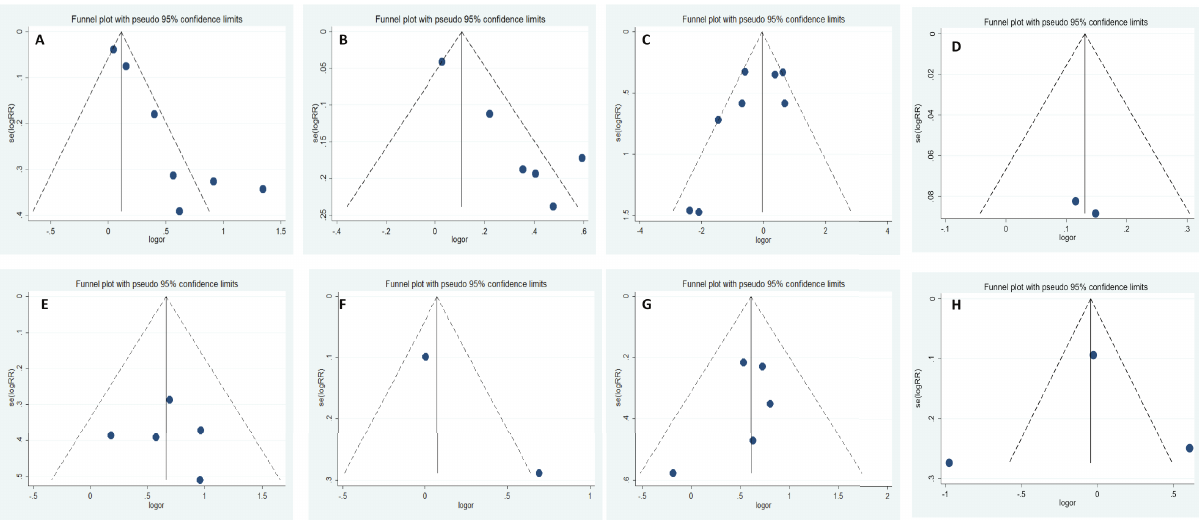
Figure 6: Funnel plot for evaluation the publication bias (A: complete response; B: partial response; C: objective response rate; D:2-year survival; E: bone marrow suppression; F: oral mucositis; G: gastrointestinal reaction; H: